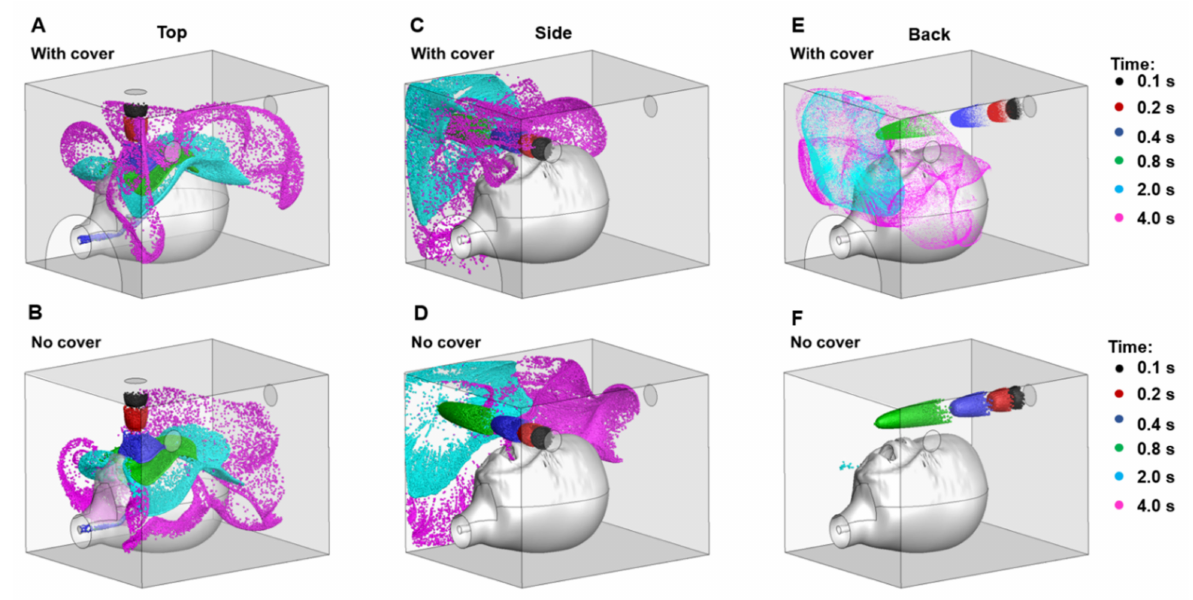
Figure 4. Snapshots of particle positions at varying increments of time after release in the hood delivery system with three nebuliser positions: top ( A , B ), side ( C , D ), and back ( E , F ), with ( A , C , E ) or without ( B , D , F ) the front